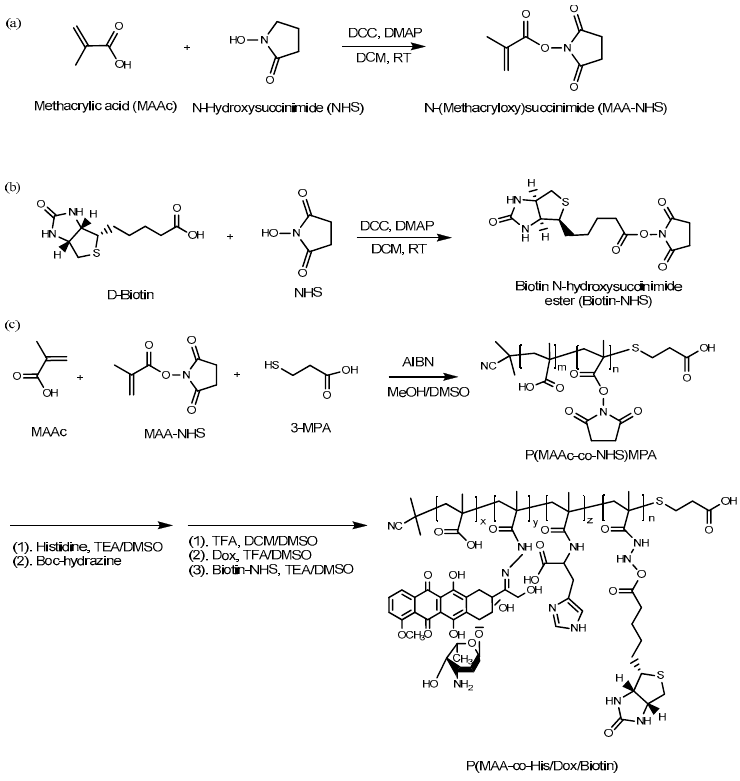
Figure 1. Synthesis protocol of ( a ) MAA–NHS, ( b ) biotin–NHS, and ( c ) P(MAAc- co -His/DOX/Biotin) copolymers.